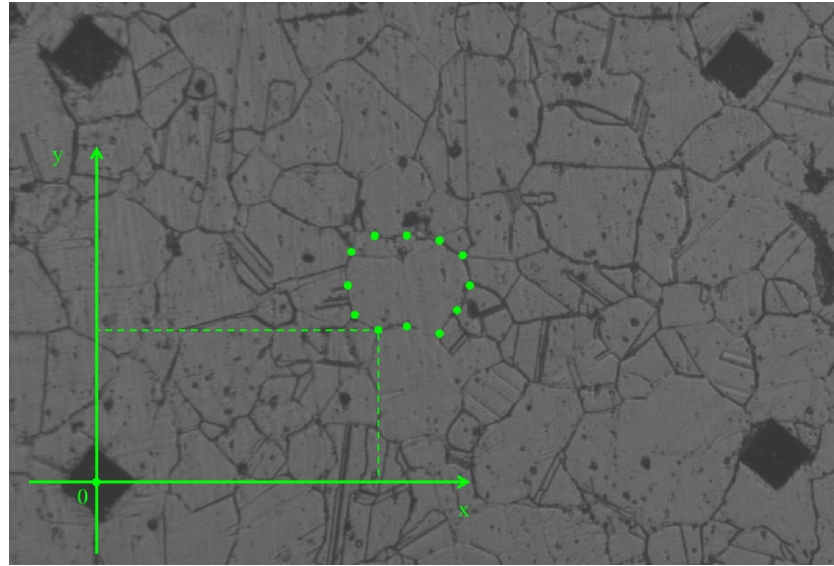
Figure 3. Twelve points on the grain contour.